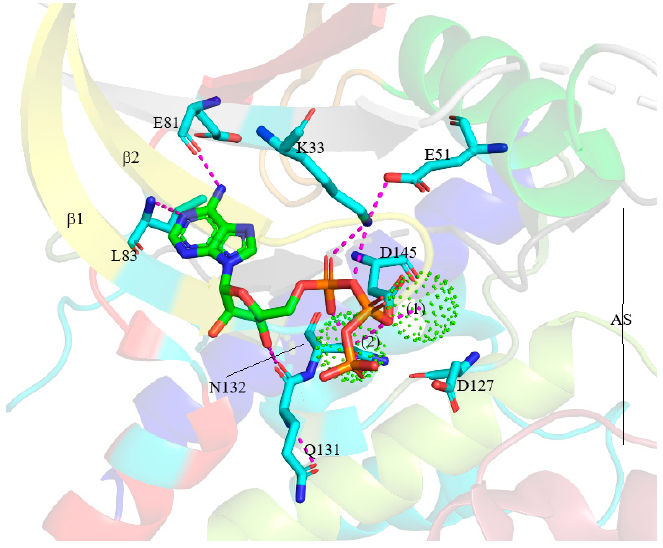
Figure 3. ATP-binding pocket of pCDK2 (PDB ID 1QMZ and 4EOQ). Mg 2+ ions are shown as spherical dots. AS: activation segment.